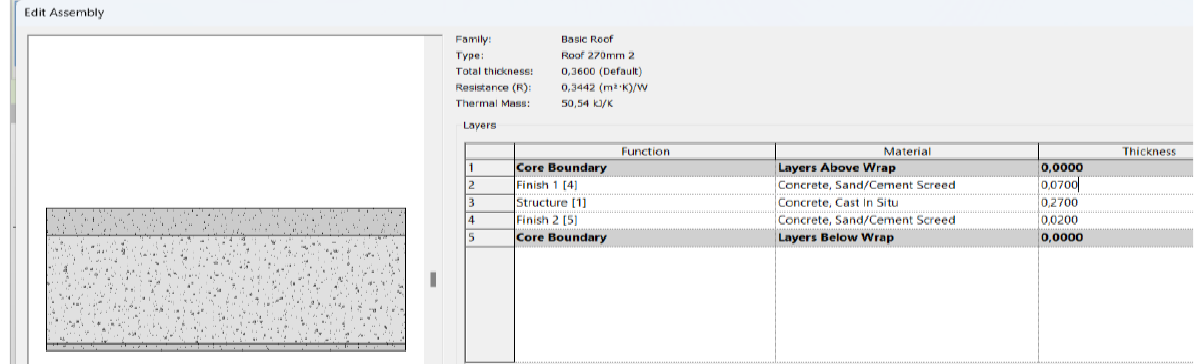
Figure A1. Roof energy analytical properties (Case 1).